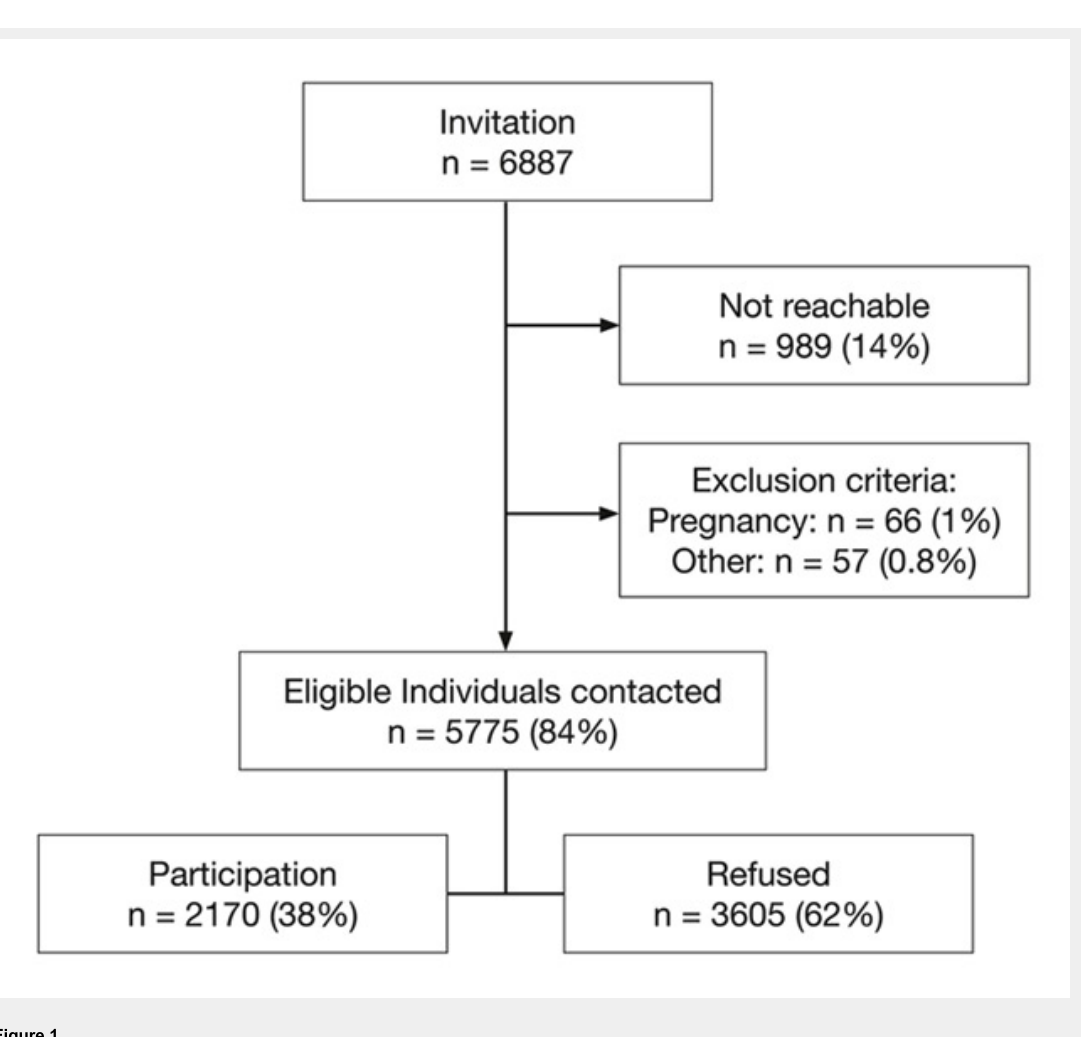
Figure 1 Recruitment of the GAPP cohort study. Flow chart of the recruitment of the GAPP